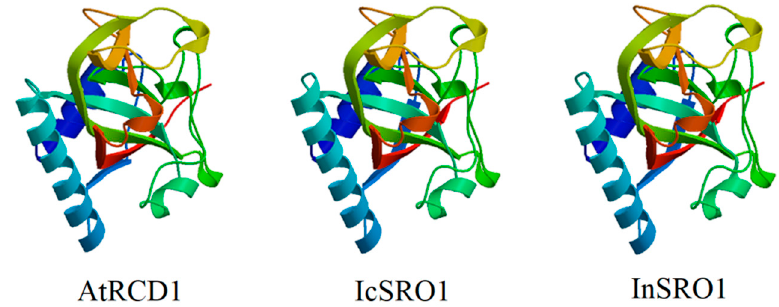
Figure 3. The 3D structure models show AtRCD1, IcSRO1 and InSRO1 share a similar structure. The model was constructed by SWISS-MODEL.